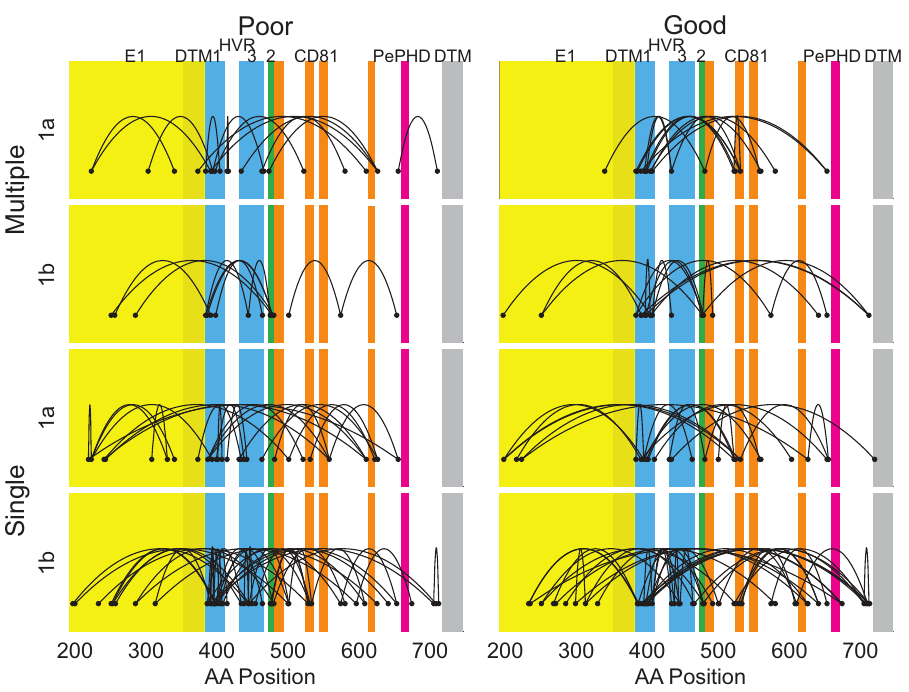
Figure 4. Mapping of optimal covarying pairs. Collections of all separating pairs in the minimal networks for each problem where selection can be within NR (Poor) or SVR (Good), for genotypes 1a and 1b, and where either only a single separating pair is chosen (Single), or multiple aa combinations are allowed for each pair (Multiple). The E1E2 sequence that ranges from aa positions of 192 to 746 is shown separated into E1 (yellow) with its transmembrane domain (DTM, darker yellow), HVR 1 and 3 (blue), with HVR2 that overlaps part of the CD81 binding site (green), the CD81 binding sites (CD81, orange and green where it overlaps with HVR2), PePHD (magenta), and the transmembrane domain for E2 (grey) [23,26].